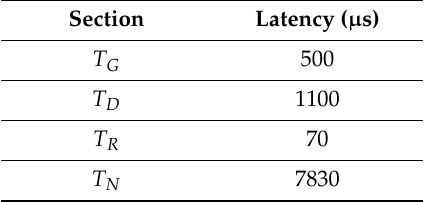
Table 2. Average latency for each section of the proposed